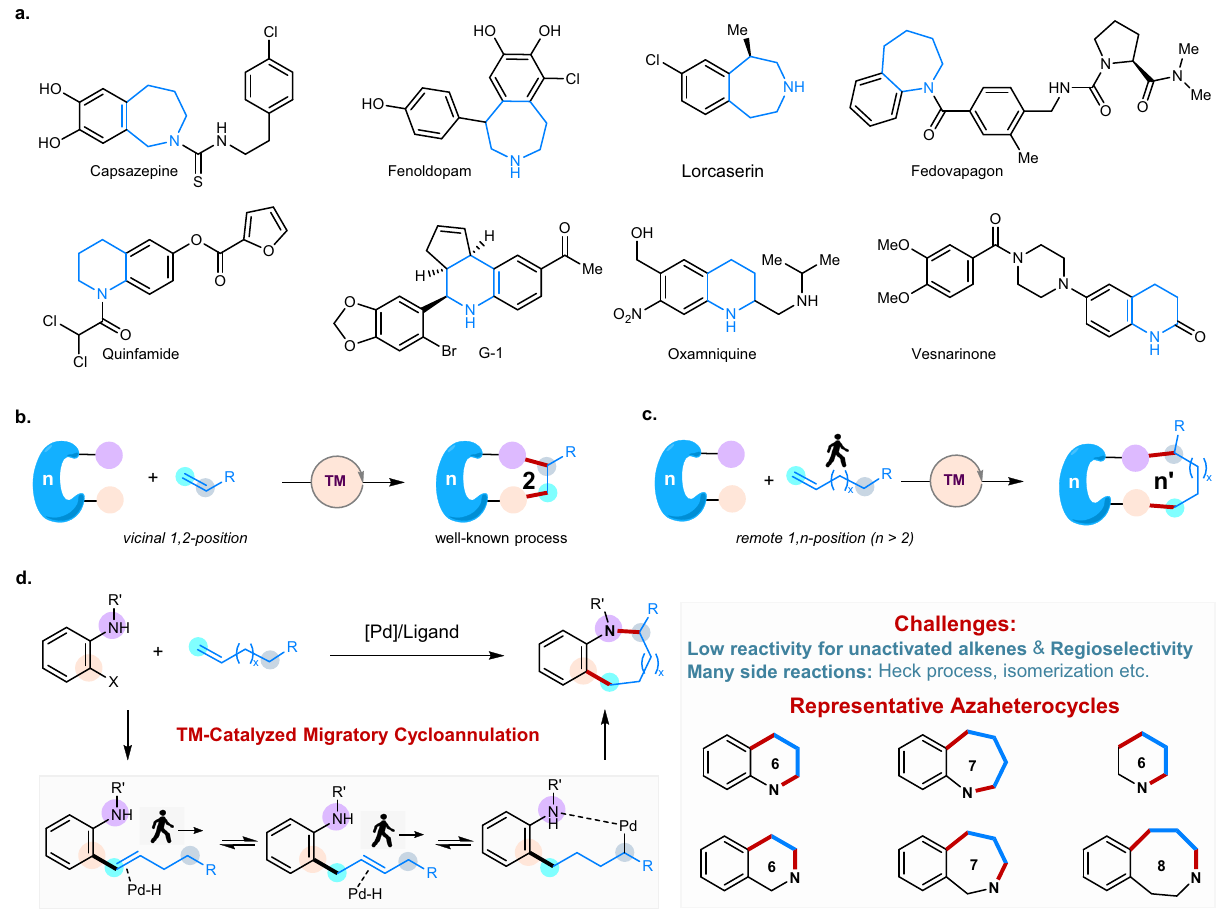
Fig. 1 | Pd-Catalyzed migratory cycloannulation reaction. a Bioactive azahe- terocycle containing drugs and natural products. b Transition metal-catalyzed [ n +2] cycloannulation with alkenes. c Transition metal-catalyzed migratory